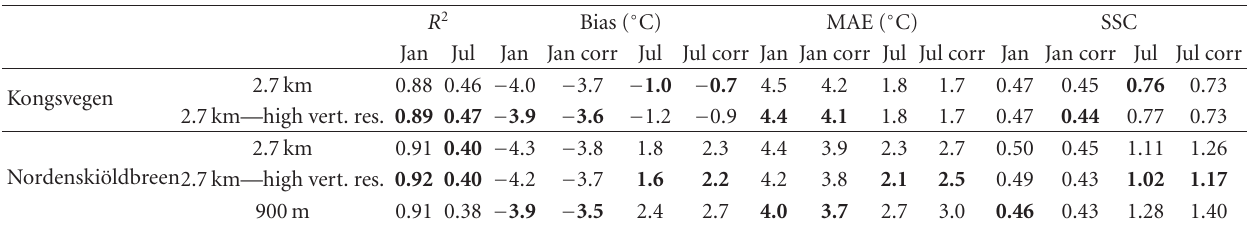
Table 13: Temperature statistics in summer and winter 2009-2010 in 2.7 km resolution, with and without increased vertical resolution in the boundary layer (high vert. res.) and in 900m resolution. Vestfonna data are not used here because of the lack of data during the chosen period. Bold numbers indicate the best result for each AWS. Abbreviation corr denotes height corrected temperatures.